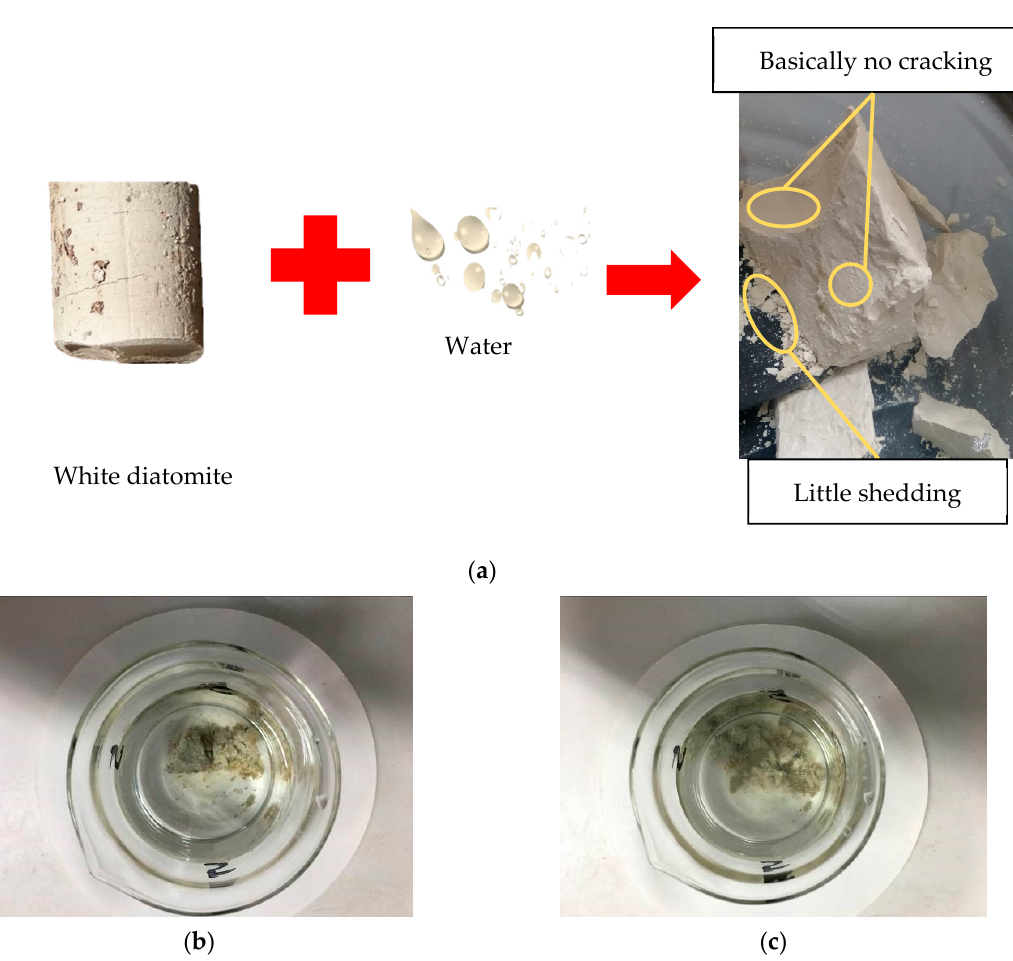
Figure 4. Hydrophysical property diagram of diatomaceous earth: ( a ) natural diatomaceous earth in contact with water; ( b ) initial stage of water disintegration of dry diatomaceous earth; and ( c ) end stage of water disintegration of dry diatomaceous earth.